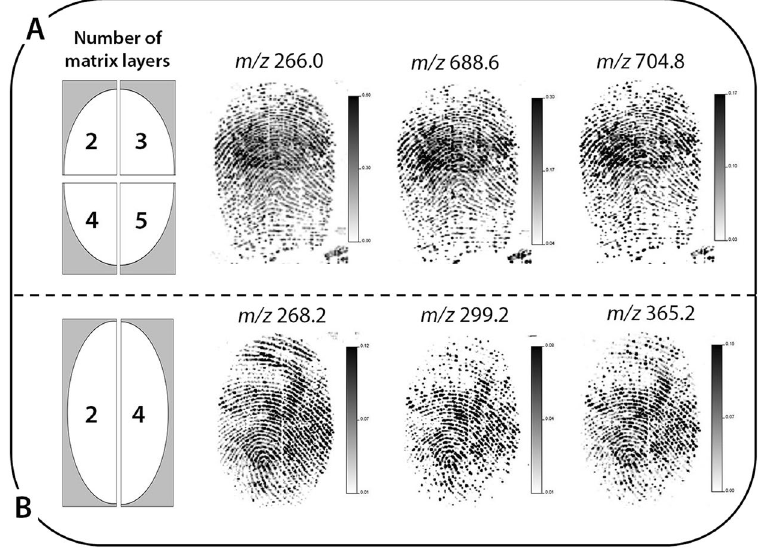
Figure 2. Optimisation of matrix deposition for fingermarks of two donors deposited onto polymer banknotes, including; ( A ) the number of matrix layers sprayed onto four quarters of fingermark 1 (donor 1) and subsequent MALDI MS images acquired, and ( B ) the number of matrix layers sprayed onto two halves of fingermark 2 (donor 2) and subsequent MALDI MS images acquired. In both cases, the quality of ridge detail is the same across each section of the marks, suggesting a 2-layer approach as the most suitable